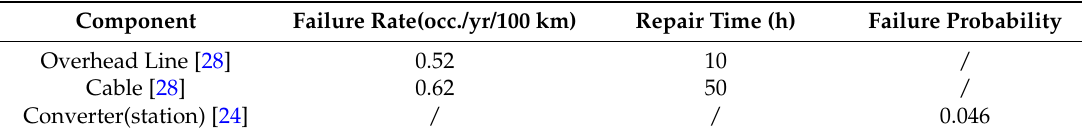
Table 2. Reliability parameters.